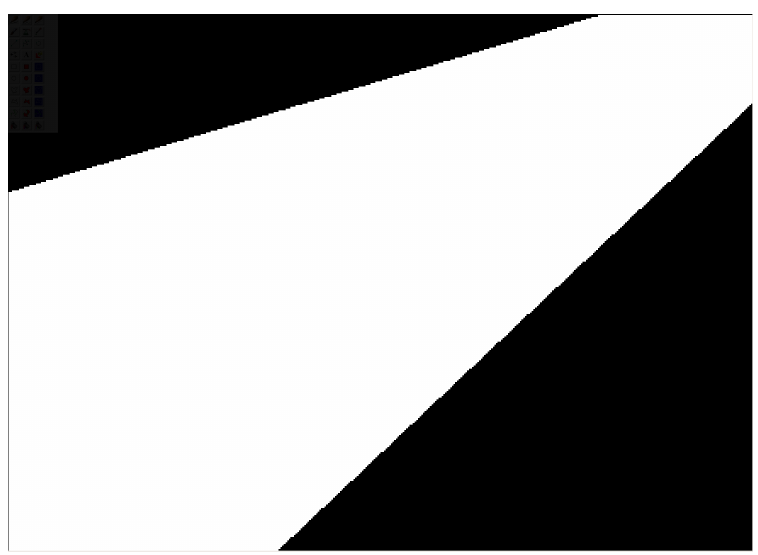
Figure 10. Exemplary mask created in the process of ROI reduction.